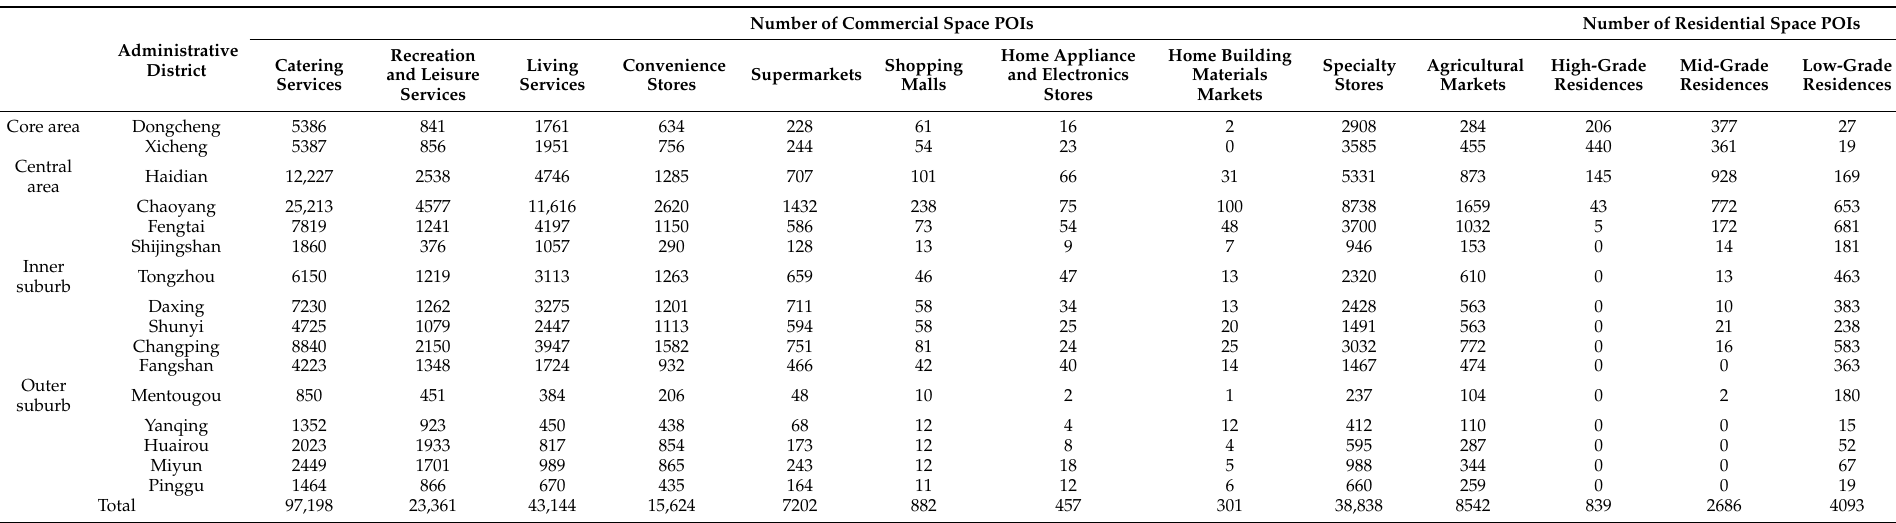
Table 2. The POI data of commercial and residential spaces in